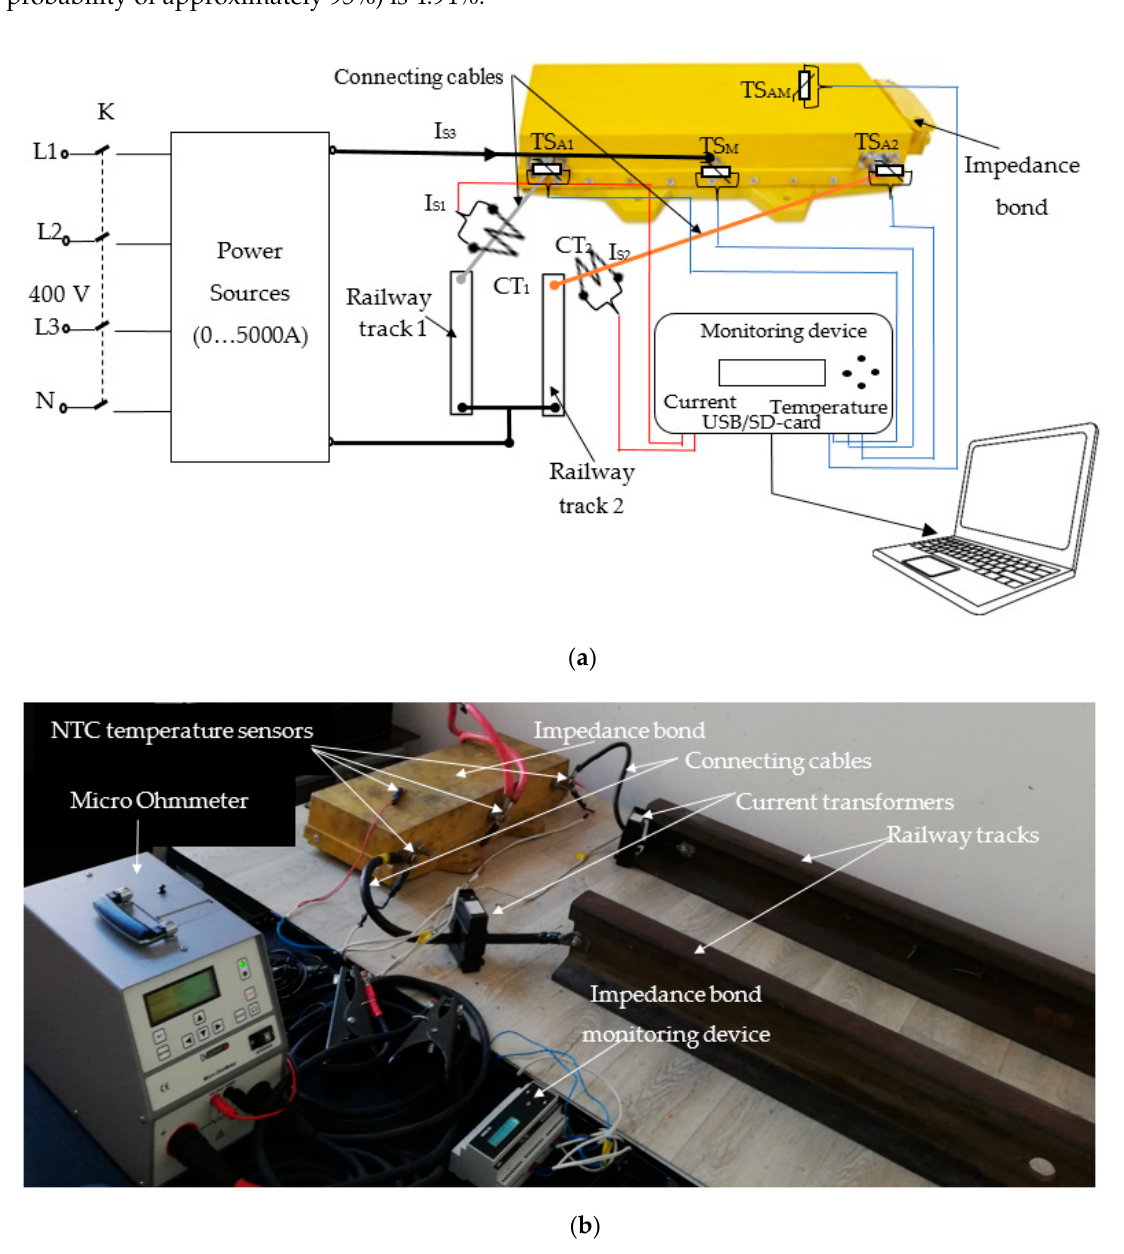
Figure 6. Experimental installation for condition monitoring of the modernized impedance bond: ( a ) the block diagram for experimental tests; ( b ) the image of the e xperimental installation.